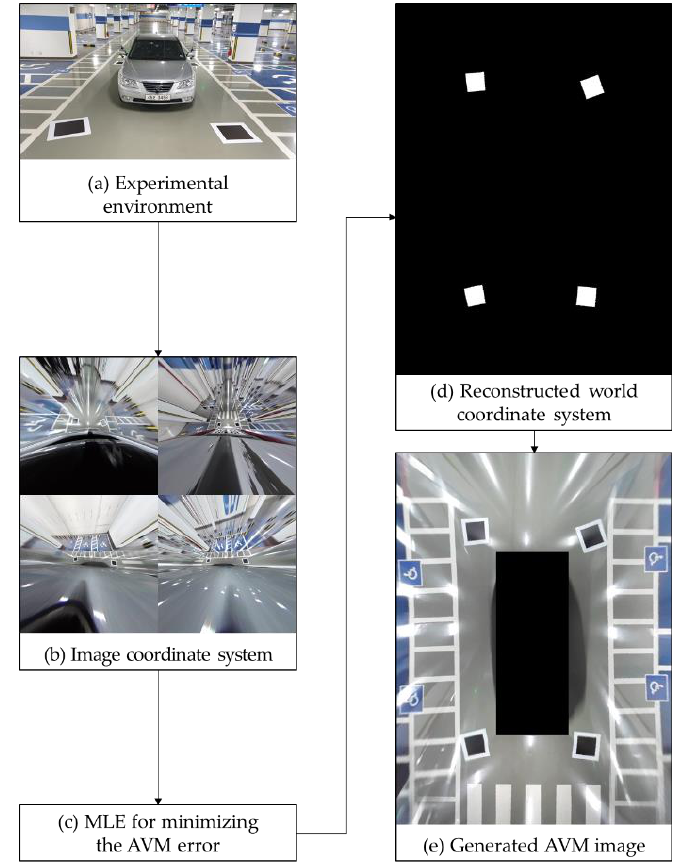
Figure 3. The procedure for the proposed AVM calibration.